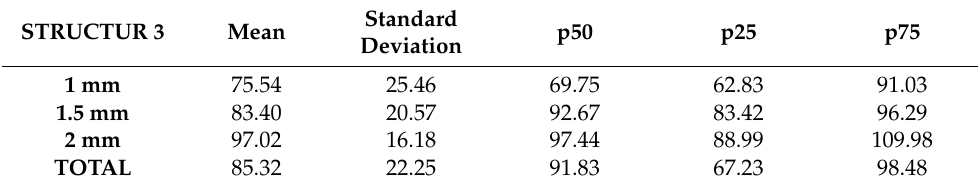
Table 3. Flexural strength vs. thickness (Structur 3).